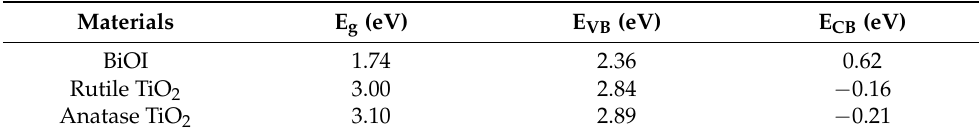
Table 3. VB and VC potentials corresponding to BiOI and TiO 2 .